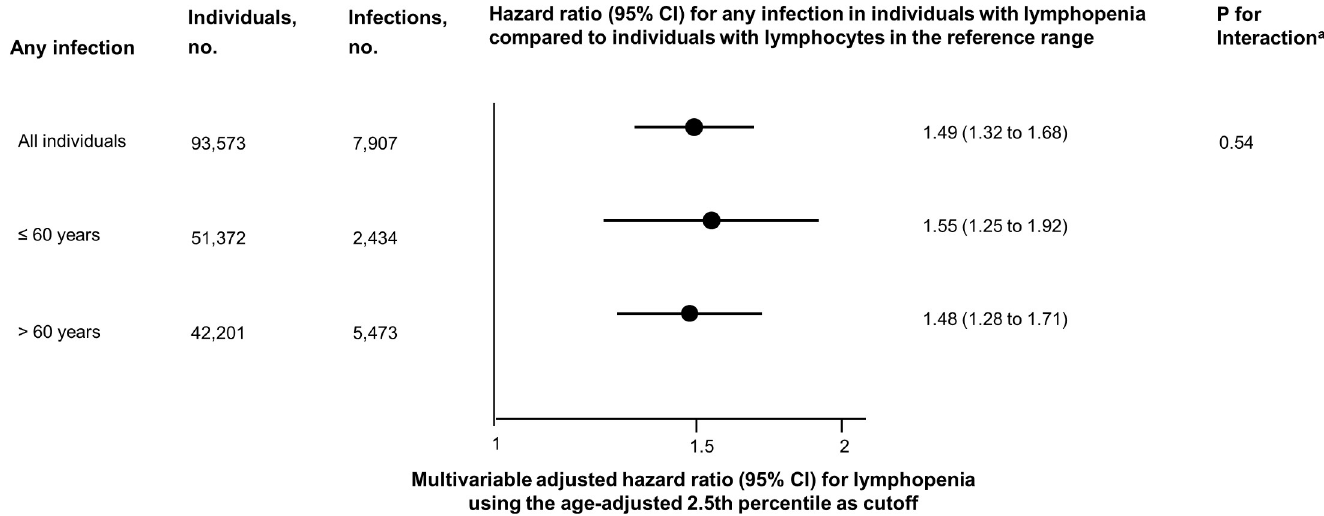
Fig 6. Multivariable adjusted risk of any infection for individuals from the Copenhagen General Population Study with lymphopenia using age-adjusted percentiles of lymphocyte count. Multivariable adjusted risk of any infection for individuals from the Copenhagen General Population Study with lymphopenia (lymphocyte count < 1.1 × 10 9 /l) compared to individuals with lymphocytes in the reference range (1.1–3.7 × 10 9 /l). Multivariable adjustment includes all covariates listed in Table 1 except age, but with age as the underlying timescale. Individuals with lymphopenia had a lymphocyte count below the 2.5th percentile in each 1-year age band. a According to a likelihood ratio